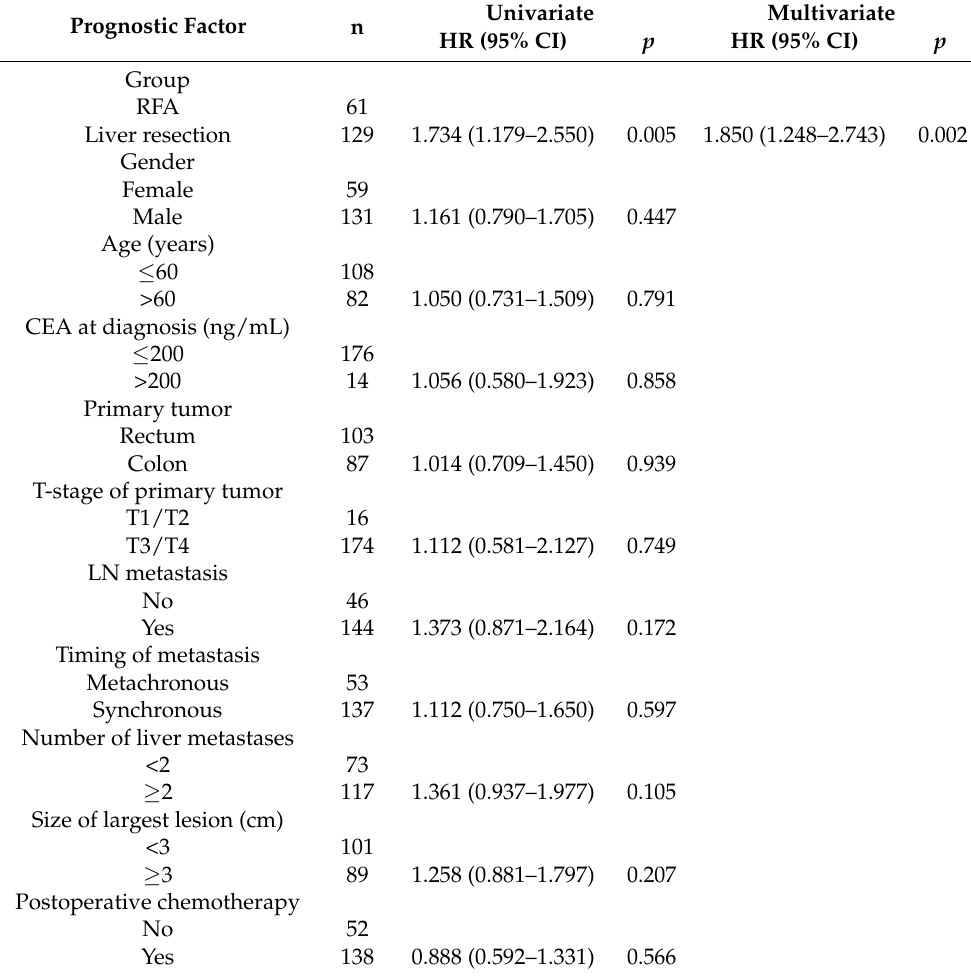
Figure 2. Kaplan–Meier survival curve for PFS of RFA and liver resection groups. ( A ): Unmatched analyses; ( B ): PSM analyses. Table 4. Analysis of prognostic factors associated with PFS.